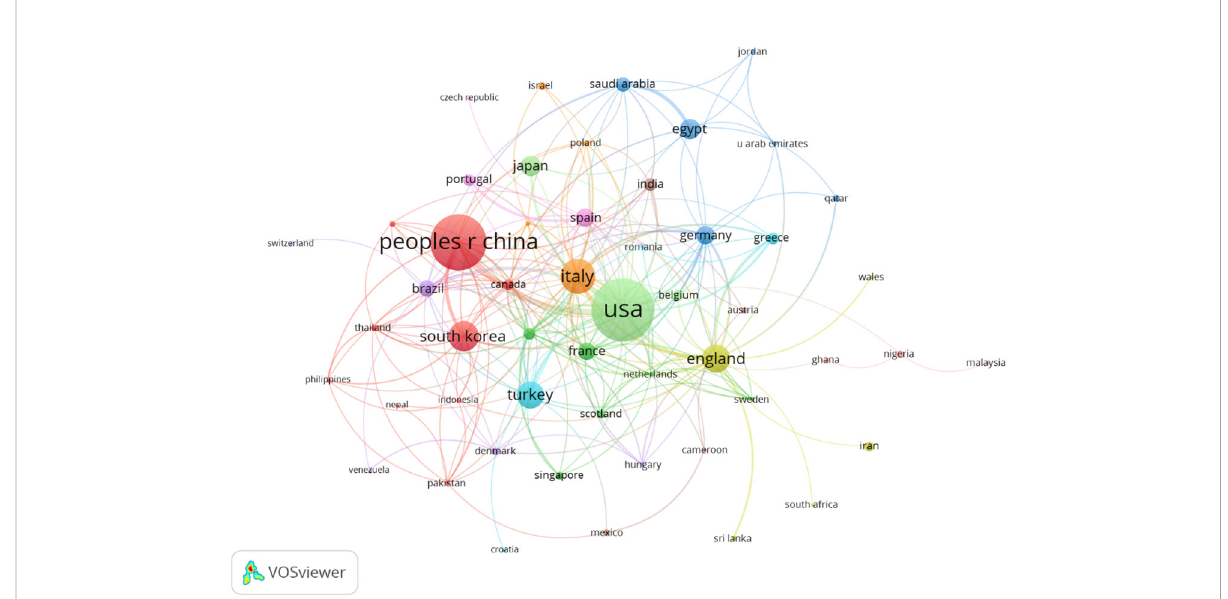
FIGURE 4 Co-occurrence map of countries/regions. The size of the nodes represents the number of articles. The thickness of the curves represents the strength of collaboration. The colors represent different collaboration